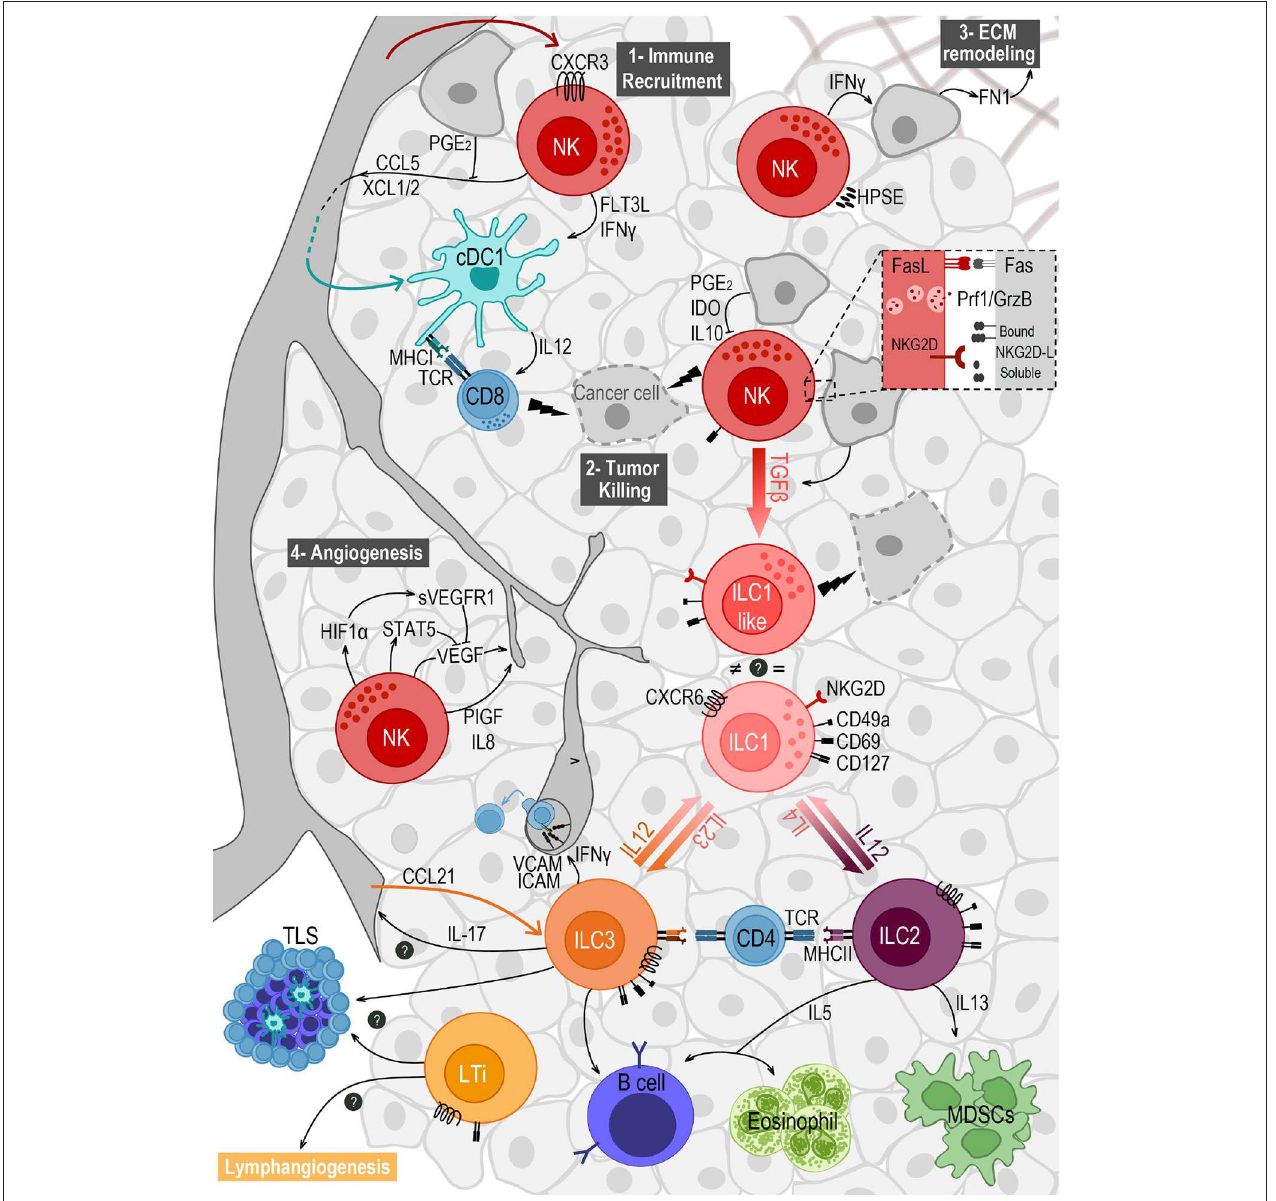
FIGURE 1 | Crosstalk of ILCs and the different components of the tumor microenvironment. NK cells are the main ILC subset found in the TME, after migrating from the blood in a CXCR3-dependent way. They play important roles in (1) immune recruitment, (2) tumor cell killing, (3) extracellular matrix (ECM) remodeling, and (4) angiogenesis. (1) NK cells recruit cDC1s to the TME by secreting CCL5 and XCL1/2, and promote their survival and maturation through FLT3L and IFN γ . (2) NK cell mediated killing is mostly achieved by the engagement of death receptors (e.g., Fas/FasL) and by the release of cytotoxic granules containing perforin (Prf1) and granzymes (GrzB). This response can be triggered by the expression of stress markers on tumor cells, recognized by the receptor NKG2D. Ligands to this receptor (NKG2D-L) are membrane-bound but can also be shed and released in soluble form. (3) NK cells express the enzyme heparanase (HPSE) to degrade heparin sulfate proteoglycans, allowing them to migrate in the tumor tissue. NK cells’ secretion of IFN γ induces the production of fibronectin 1 (FN1) by tumor cells, further remodeling the ECM. (4) NK cells modulate angiogenesis by releasing VEGF, PIGF and IL-8. VEGF secretion can be repressed by STAT5 or by soluble VEGF receptor (sVEGFR1) induced as a response to hypoxia. Tumor cells’ secretion of TGF β induces the conversion of NK cells into ILC1-like cells expressing CD49a and CD69, and exhibiting anti-tumor cytotoxic activity. Plasticity within the ILC family also includes the conversion from ILC2 to ILC1, and from ILC3 to ILC1, both induced by IL-12 and reversed by IL-4 and IL-23, respectively. ILC2s have a pro-tumorigenic role via secretion of IL-13 driving the expansion of myeloid-derived suppressor cells (MDSCs), and an anti-tumorigenic role through IL-5 mediated recruitment of eosinophils and activation of B cells. ILC3 can also stimulate antibody production by B cells, and can favor leukocyte recruitment to the TME when sensing IL-12, through IFN γ -mediated upregulation of ICAM-1 and VCAM-1. They may also play a role in angiogenesis through the production of IL-17. NCR + ILC3s and LTis accumulate in tertiary lymphoid structures (TLS) and may also promote lymphangiogenesis. Finally, both ILC2 and ILC3 express MHC class II and were able to prime CD4T cells in vitro .